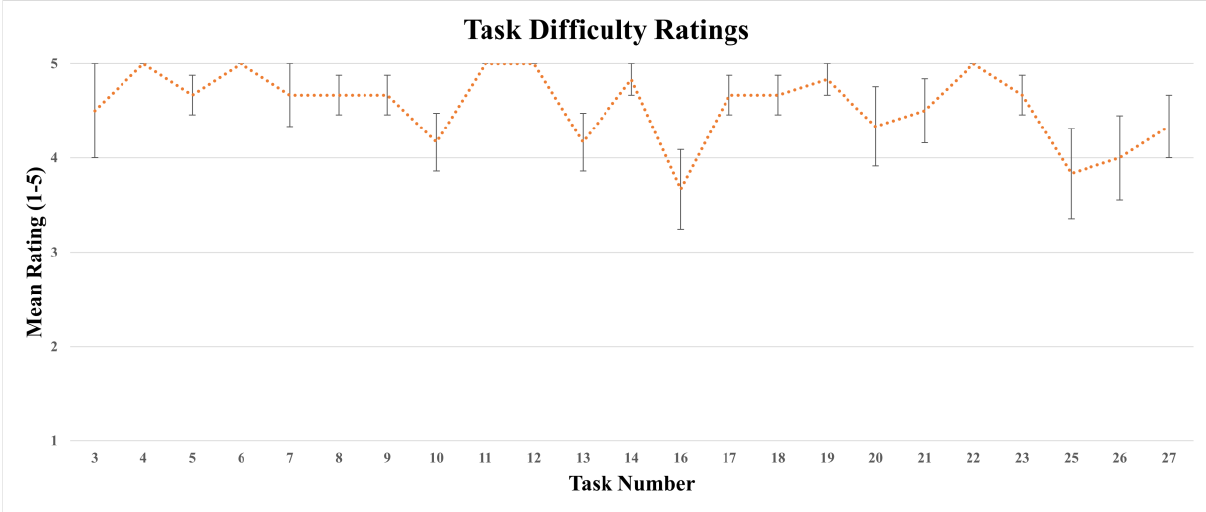
Figure 3. Task difficulty rating and standard error for the question “ How easy was this task to complete? ”, collapsing over six participants. These self-reported ratings identified software pressure points for each individual task of the sound awareness session and lower ratings (below 3) served as discussion points for an exit interview.